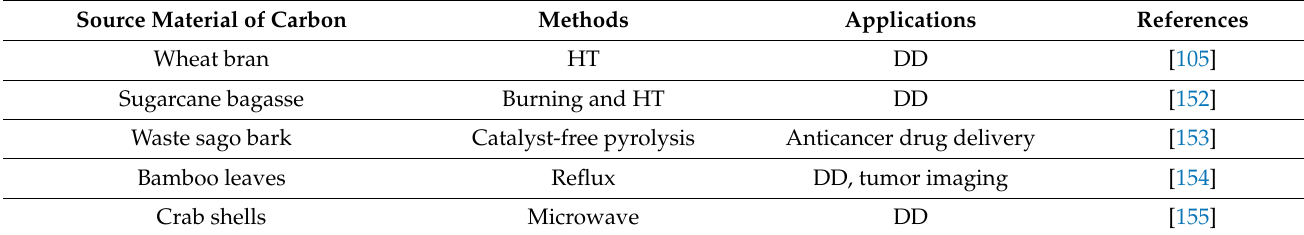
Table 12. Applications of C-dots in drug delivery.